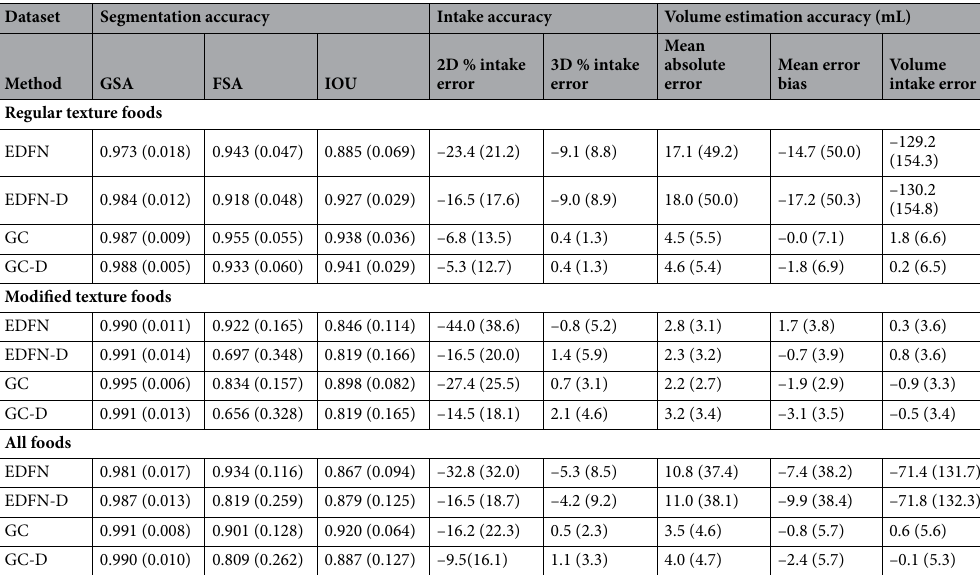
Table 2. Comparative analyses of system performance within and across LTC datasets between our proposed method (EDFN, EDFN-D) and the “applied ground truth” graph cuts (GC, GC-D). % error intake refers to the proportion of segmented pixels calculated using the predicted estimate minus the target ground-truth hand segmented regions; 2D: no-depth, 3D: with depth-refinement. Values are (mean ± SD) GSA: Global segmentation accuracy, FSA: Food segmentation accuracy, IOU: intersection over